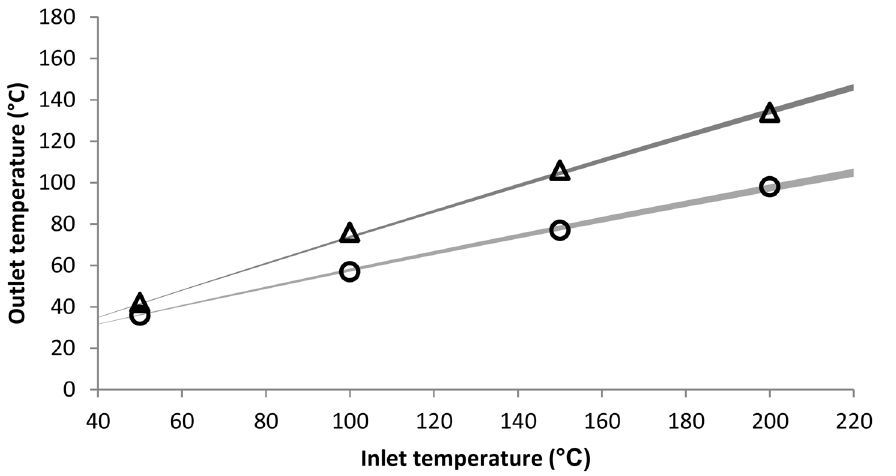
Figure 3. Modeled (grey) and experimental (black) outlet temperature used to determine d air . Aspirator flow was set at either 12 m 3 n /hr (circle) or 22 m 3 n /hr (triangle), while the liquid feed flow was kept constant at 0 mL/min. Thickness of the lines indicate the 95% confidence interval of the modeled outlet temperature.